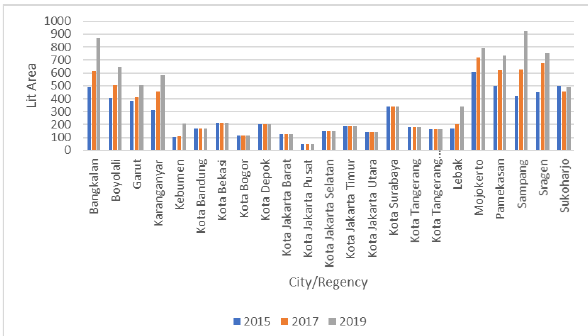
Figure 5. Lit areas in 2015, 2017, and 2019 per